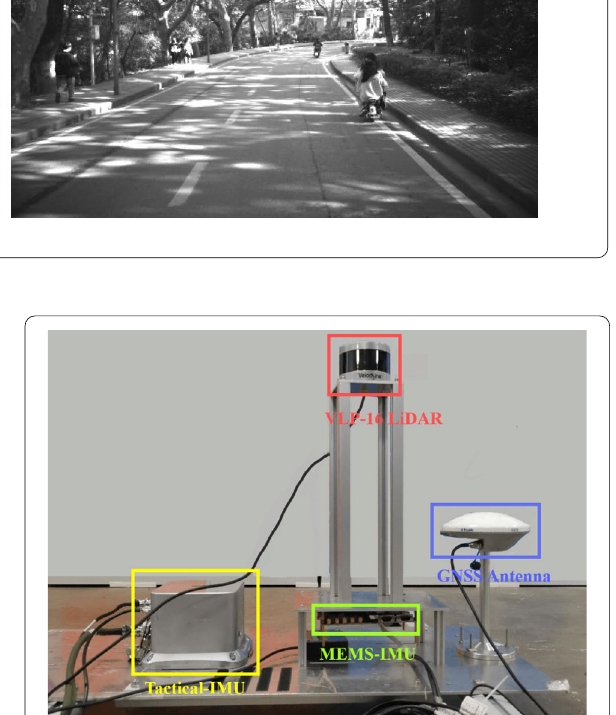
Fig. 4 Installation of the experimental